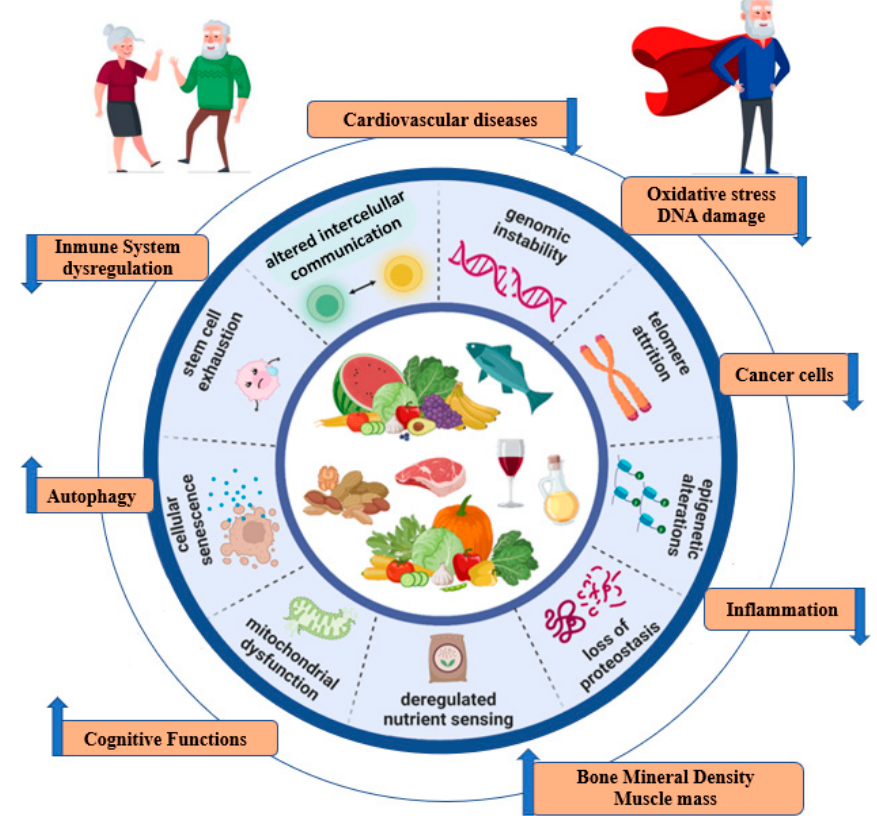
Figure 1. Impact of MedDiet on the hallmarks of aging.